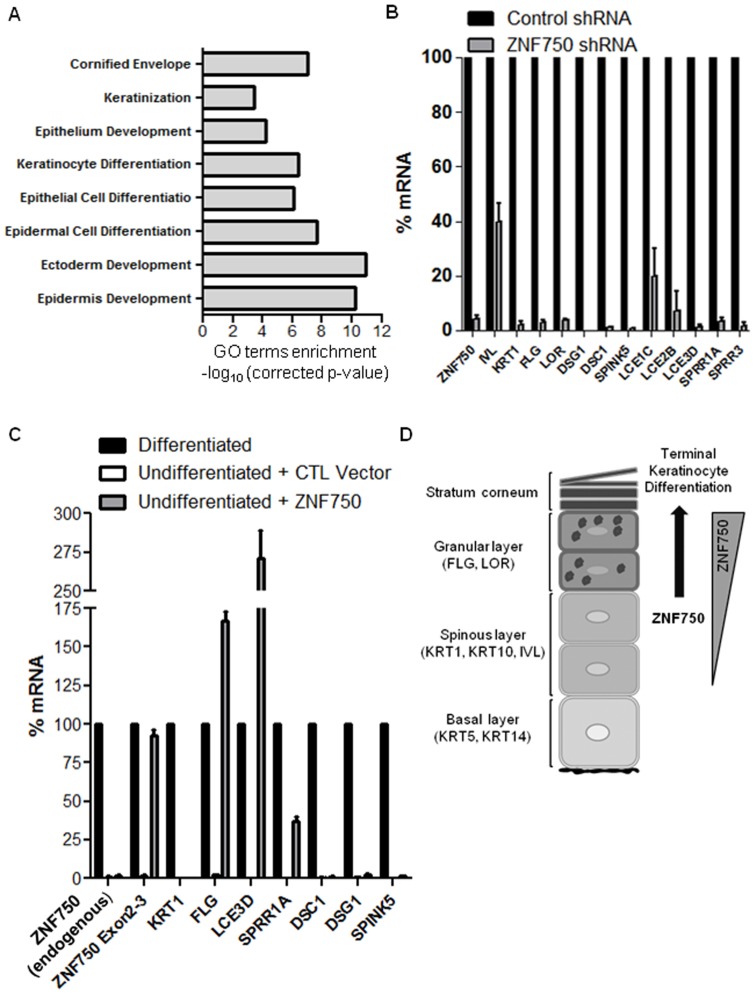
ZNF750 regulates keratinocyte terminal differentiation.(A) Gene Ontology terms for the 256 genes that were downregulated in ZNF750 silenced cultures vs. control (P-value<0.05, FC≥2), with Bonferroni-corrected p-value<0.001. (B) QRT-PCR mRNA expression of a selected group of terminal differentiation genes in control vs. ZNF750 silenced cultures, that showed downregulation fold change≥2. Error bars represent mean values±SD, N = 2. (C) mRNA expression (QRT-PCR) of a selected group of terminal differentiation genes in differentiated cells vs. undifferentiated HaCaT cells that overexpress ZNF750 or an empty control vector (CTL). Cells in undifferentiated state were maintained at sub-confluence in low calcium media. Expression levels are shown relative to those of Ca2+-induced differentiated HaCaT cultures at day twelve (100%). Two sets of primers targeting ZNF750 were used: “ZNF750 endogenous” PCR amplifies the ZNF750 5′ UTR, representing the ZNF750 endogenous expression only, and serves as an internal control demonstrating the cells' undifferentiated state. The ZNF750 Exon2-3 primer set PCR amplifies ZNF750 coding sequence common to the endogenous and exogenous ZNF750 molecules. Note that in the CTL control group mRNA levels of all tested markers were practically null. Error bars represent mean values±SD, N = 2. (D) Schematic representation: ZNF750 expression is gradually augmented throughout keratinocyte differentiation, inducing expression of late differentiation markers.